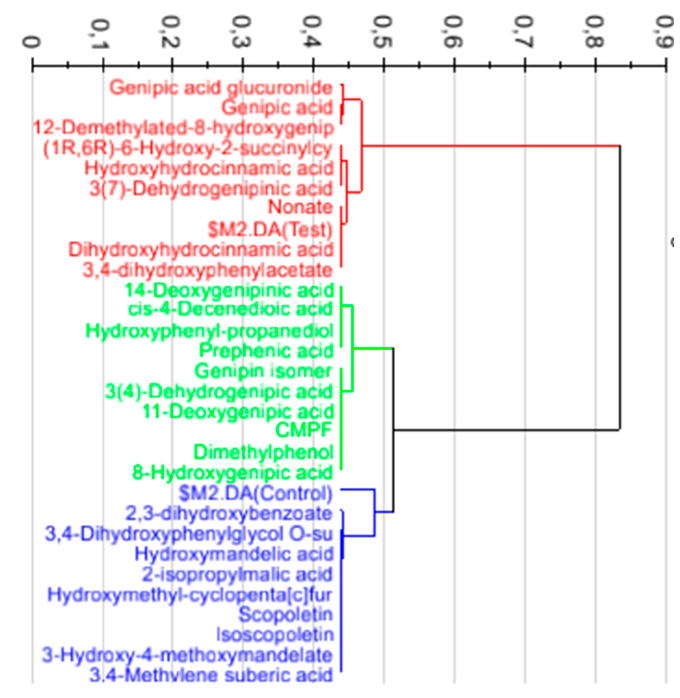
Figure 4. Hierarchical clustering analysis of the PLS-DA loadings showing the metabolites most closely clustering with the consumers’ ($M2.DA (Test in red)), the group of metabolites less well associated with the control (in green), and non-consumers’ metabolome ($M2.DA (Control in blue)).